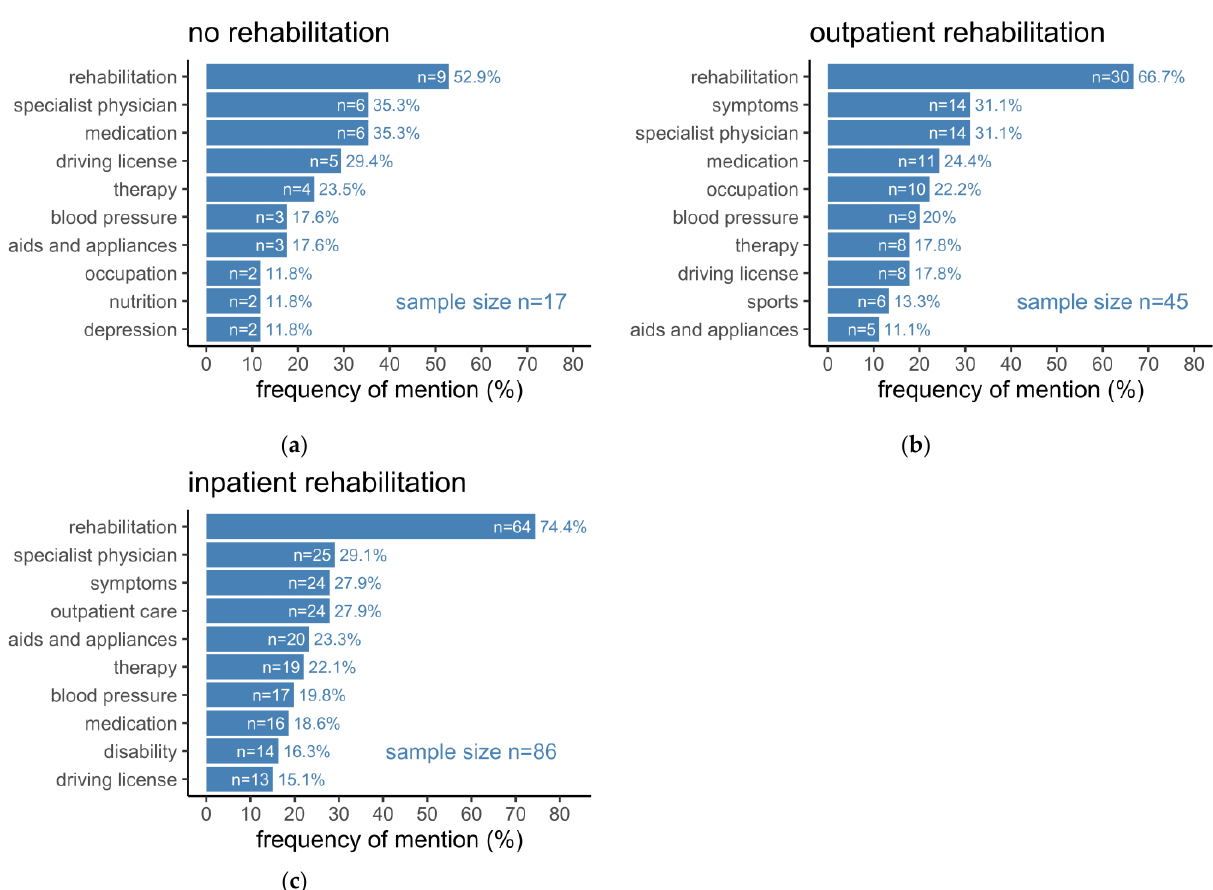
Figure 3. ( a ) Topics mentioned by patients who have not attended rehabilitation; ( b ) Topics mentioned by patients who have attended outpatient rehabilitation; ( c ) Topics mentioned by patients who have attended inpatient rehabilitation. Bars represent the number of patients (n) who mentioned a specific topic. Added rates represent the percentage of patients (%) with respect to the underlying sample